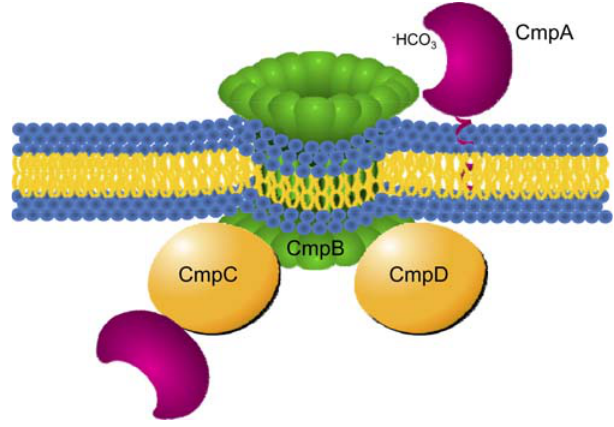
Figure 1. Schematic representation of the ABC-type transport- ers of bicarbonate in Synechococcus . The Substrate Binding Protein CmpA is presumably anchored to the periplasmic face of the cytoplasmic membrane via a lipid anchor attached to a conserved cystine at the end of a lipoprotein signal peptide [45]. The SBP domain is composed of two domains organized in a C-clamp shape [23]. In Synechococcus , a SBP domain is also present intracellularly at the carboxy terminal end of the CmpC ATPase subunit. The CmpC protein is absent in B. anthracis and in S. pyogenes . Also, in S. pyogenes , the SBP domain is fused at its C-terminal end to the CmpB-like permease domain.